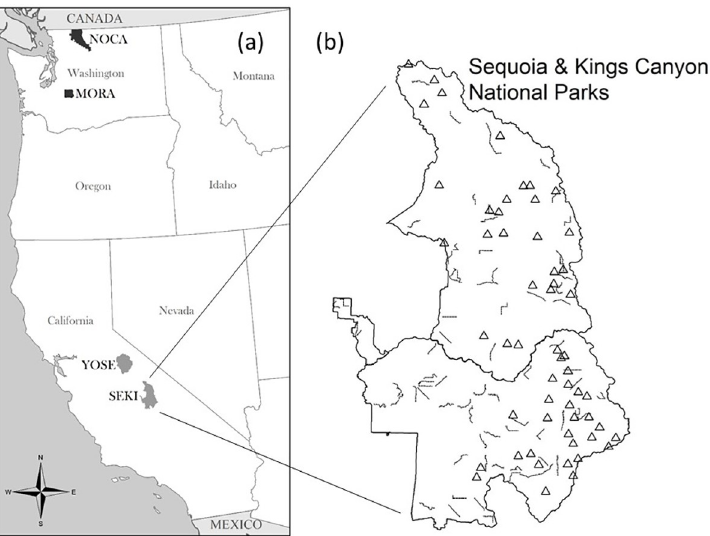
Fig 1. National park units monitored for this study. (a) Whitebark pine and Clark’s nutcracker were monitored in Mount Rainier (MORA), North Cascades (NOCA), Yosemite (YOSE) and Sequoia and Kings Canyon (SEKI) national parks. Darker shading indicates parks in the North Coast and Cascades Inventory and Monitoring Network (NCCN) and lighter shading indicates parks in the Sierra Nevada Inventory and Monitoring Network (SIEN). (b) An example of the typically non-overlapping distribution of avian point-count transects (lines) and tree survey plots (triangles) within a park (here,